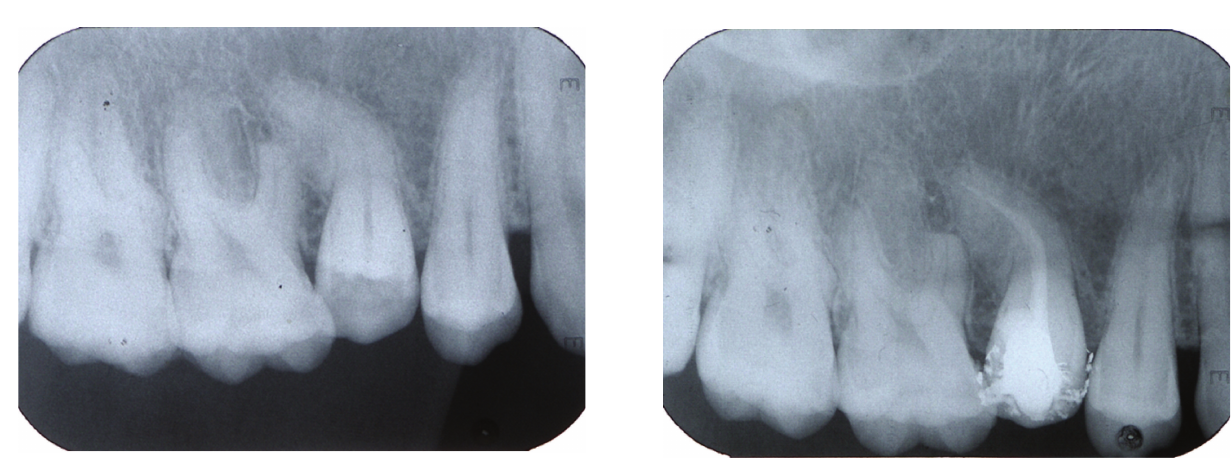
Figure 3: Postoperative radiograph following root canal treatment of the